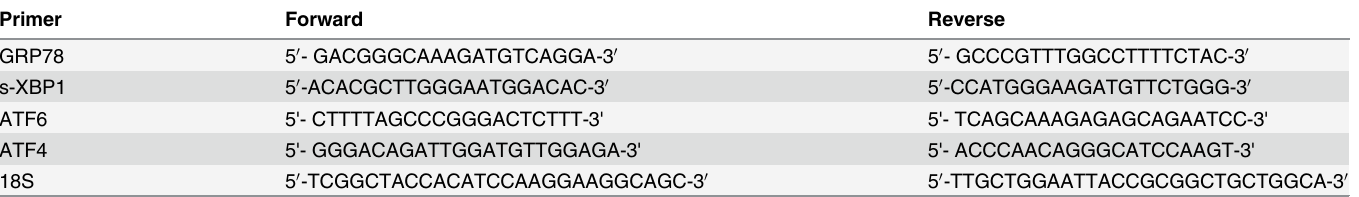
Table 1. Gene-specific primer sequences for real-time PCR.